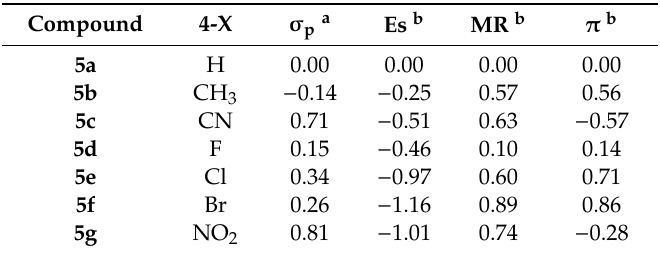
Table 2. Electronic, steric and lipophilic parameters: Hammett constant ( σ p ), Taft constant (Es), molecular refractivity (MR), and Hansh constant ( π m